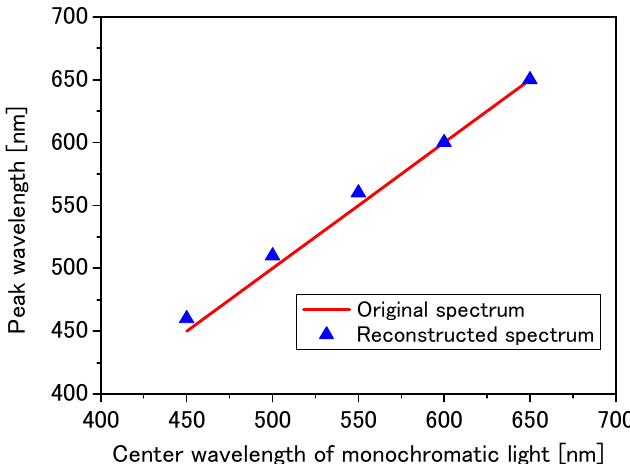
Figure 11. Spectral reconstruction.